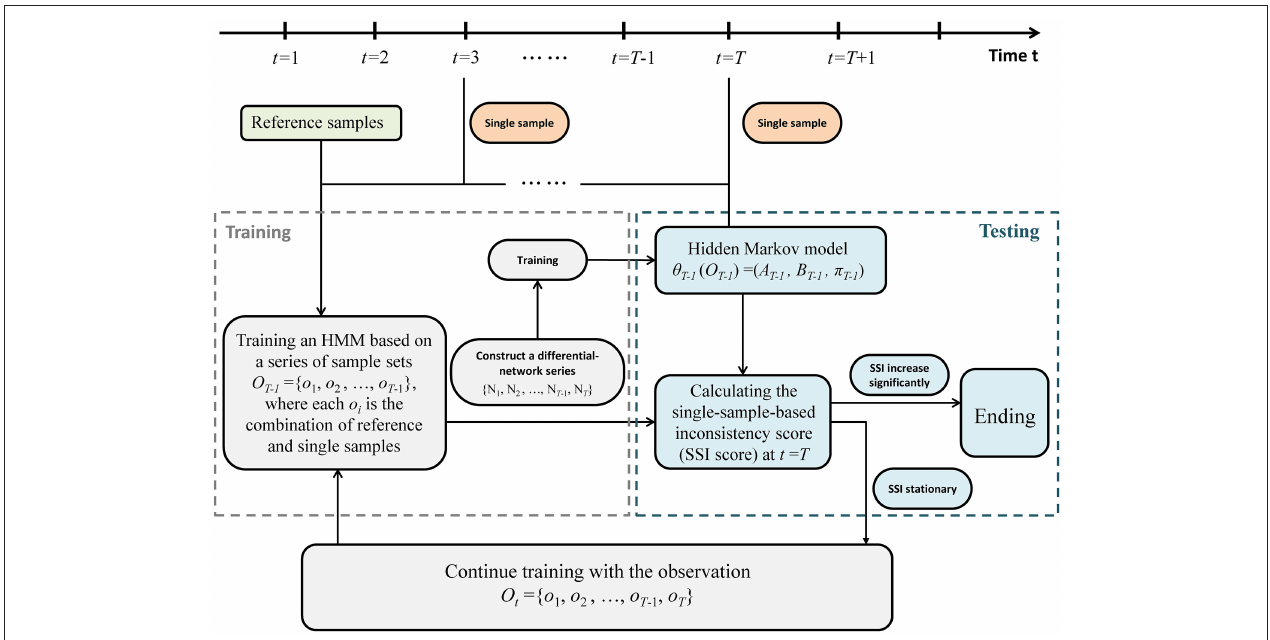
FIGURE 2 | The algorithm of the single-sample-based HMM. The above flowchart shows how the algorithm works based on a series of single case samples. Regarding a point t = T ( T > 2) as a candidate tipping point, the sample series is divided into training part ranging from t = 1 to t = T − 1, and testing part starting from t = T . If a probabilistic score (single-sample-based inconsistency score, SSI score) increases significantly, then the candidate t = T is determined as the identified tipping point, and the algorithm ends. Otherwise, if there is no significant change in SSI score, then t = T is classified as a time point belonging to the normal state, and the algorithm continues with t = T + 1 being a new candidate tipping